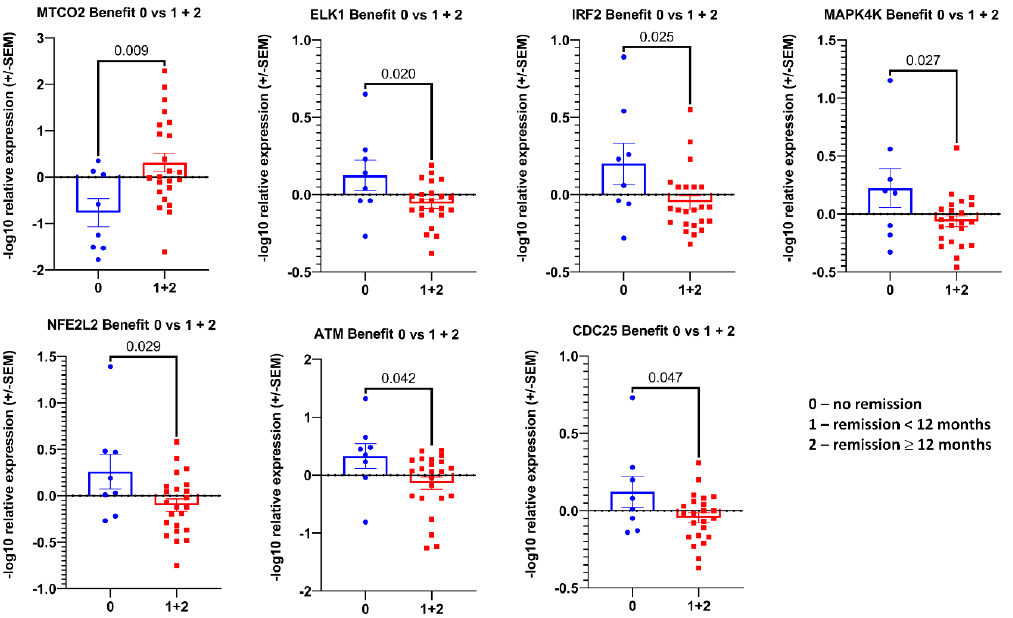
Figure 4. The association between transcripts ’ expression in blood-derived mRNA and treatment response. Log10 relative expression levels of gene transcripts were tested for association with benefit. p values are indicated after unpaired t-tests between two groups. Only the significant associations in overall cohort are depicted for RT benefit. The meaning of the number-coding is as indicated in the figure key.